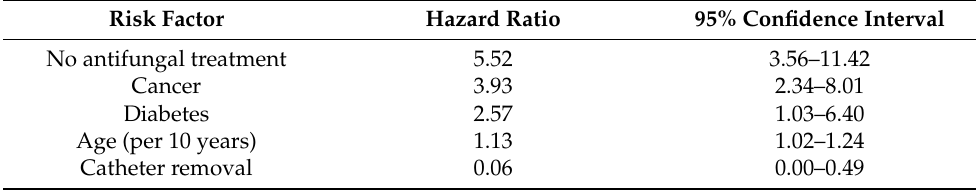
Figure 2. Survival analysis of patients with candidemia according to the presence of cancer. Note: The coloured shadow shows the 95% confidence interval. Table 4. Identified risk factors for mortality in patients with candidemia in Colombia.